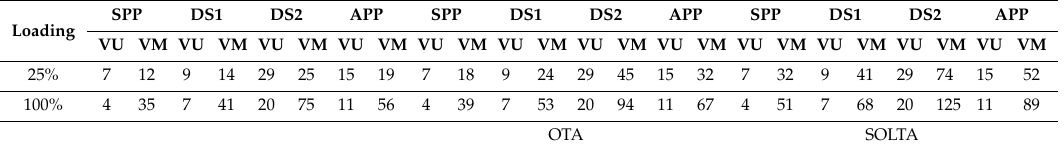
Figure 7. Performance index for voltage magnitude and voltage unbalance with minimum loading. Table 3. Steady-state PV penetration limits for each case. SPP: single phase penetration; DS1: Distribution Scheme 1; DS2: Distribution Scheme 2; APP: alternate phase penetration; OTA: o ffl ine tap adjustment; SOLTA: switched on-load tap